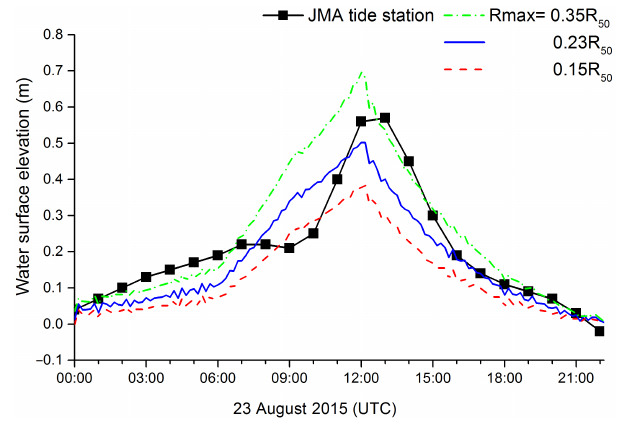
Figure 7. Comparison of observed and simulated storm surges dur- ing the passage of Typhoon Goni in 2015. The water level was observed at the tide station of Ishigaki-jima, which is located at 24 ◦ 20 (cid:48) N and 124 ◦ 10 (cid:48) E.